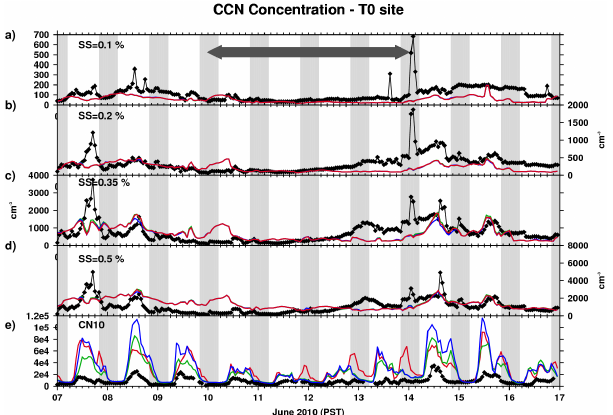
Figure 20. Observed and simulated time series of CCN number concentration at the T0 site for (a) SS = 0.1%, (b) SS = 0.2%, (c) SS = 0.35%, and (d) SS = 0.5% together with (e) CN 10 concen- tration. The gray shading area indicates nighttime, while the black arrow denotes the northerly synoptic flow associated with the pas- sage of troughs over California.